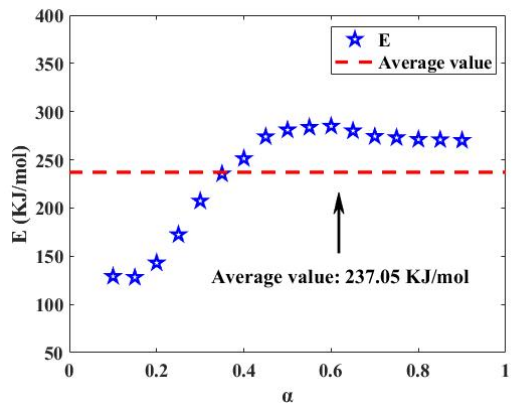
Figure 3. The E– α diagram of the whole reaction is based on Figure 2a.